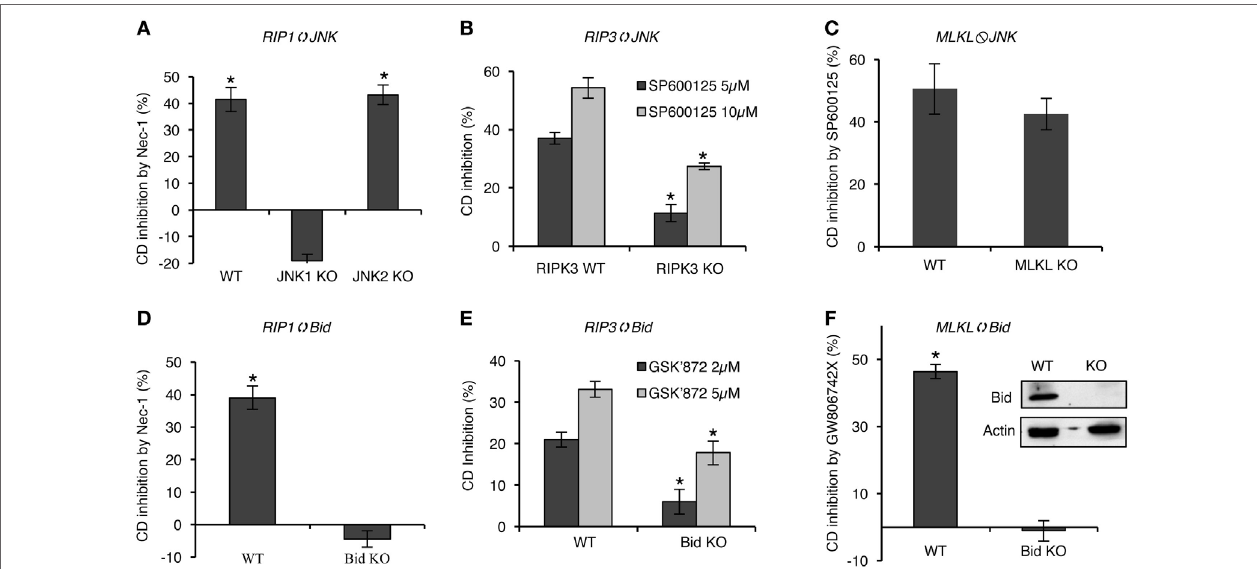
FigUre 8 | Bid and JNK are involved in receptor-interacting protein kinase 1/receptor-interacting protein kinase 3 (RIPK3)/mixed lineage kinase domain-like protein (MLKL) signaling, leading to complement-induced necrosis. General protocol: cells were pretreated with the indicated inhibitor for 1 h at 37°C and then treated with NHS for 1 h, at 37°C. The percentage of necrotic cell death (CD) and the percentage of CD inhibition by the inhibitor, relative to DMSO, were calculated (after data conversion to y /1 − y) as explained in Section “Materials and Methods.” * P < 0.01 relative to DMSO (a,c,D,F) or between WT and KO cells (B,D) ( t -test). (a) WT, JNK1, or JNK2 mouse embryonic fibroblasts (MEFs) were pretreated with necrostatin-1 (Nec-1) (50 µM) or DMSO as control. (B) WT and RIPK3 KO MEFs were pretreated with SP600125 or DMSO as control. (c) WT and MLKL KO MEFs were treated with 10 µM SP600125 or DMSO. (D) WT or Bid KO MEFs were treated with Nec-1 or DMSO. (e) WT or Bid KO MEFs were pretreated with GSK’872 at 2 or 5 µM or with DMSO as control. (F) WT or Bid KO MEFs were treated with 1 µM GW806742X or DMSO. All results represent at least three independent